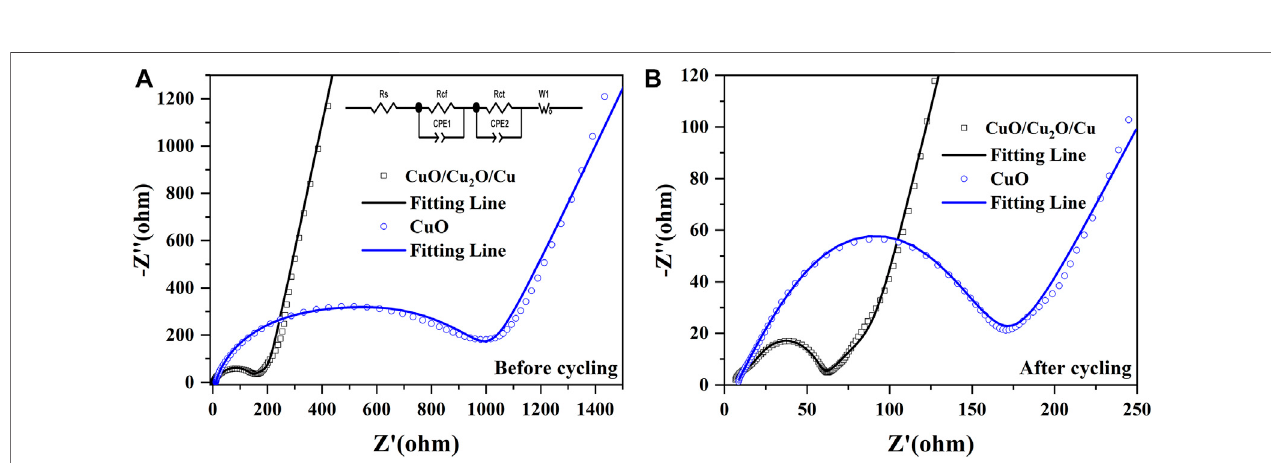
FIGURE 6 | The electrochemical impedance spectroscopy of CuO/Cu 2 O/Cu nanocomposites and CuO nanowires before (A) and after (B) cycling between 10 – 2 Hz and 10 5 Hz. The inset of (A) is the equivalent circuit.